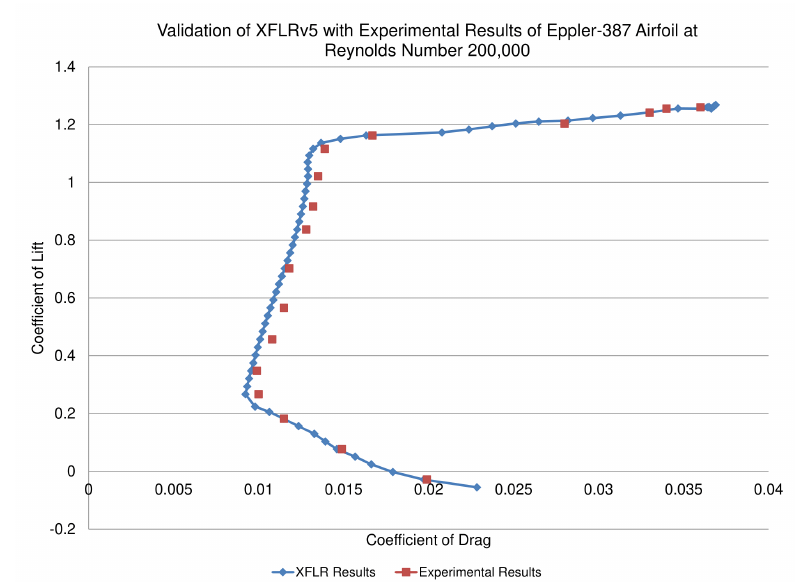
Figure 3. Comparison of numerical results obtained from XFLRv5 with experimental results obtained from [29] for E387